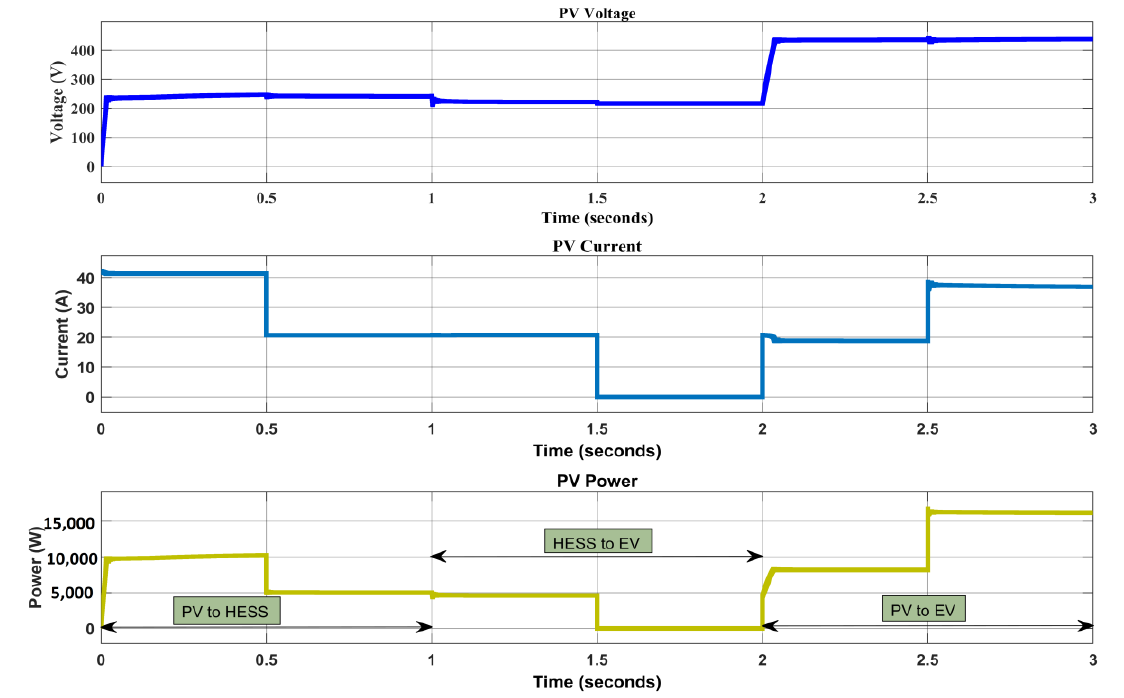
Figure 19. PV Voltage, Current and Power for different modes of operation at an irradiance of [0.5, 0.8, 1, 0.8, 0.9] *1,000.